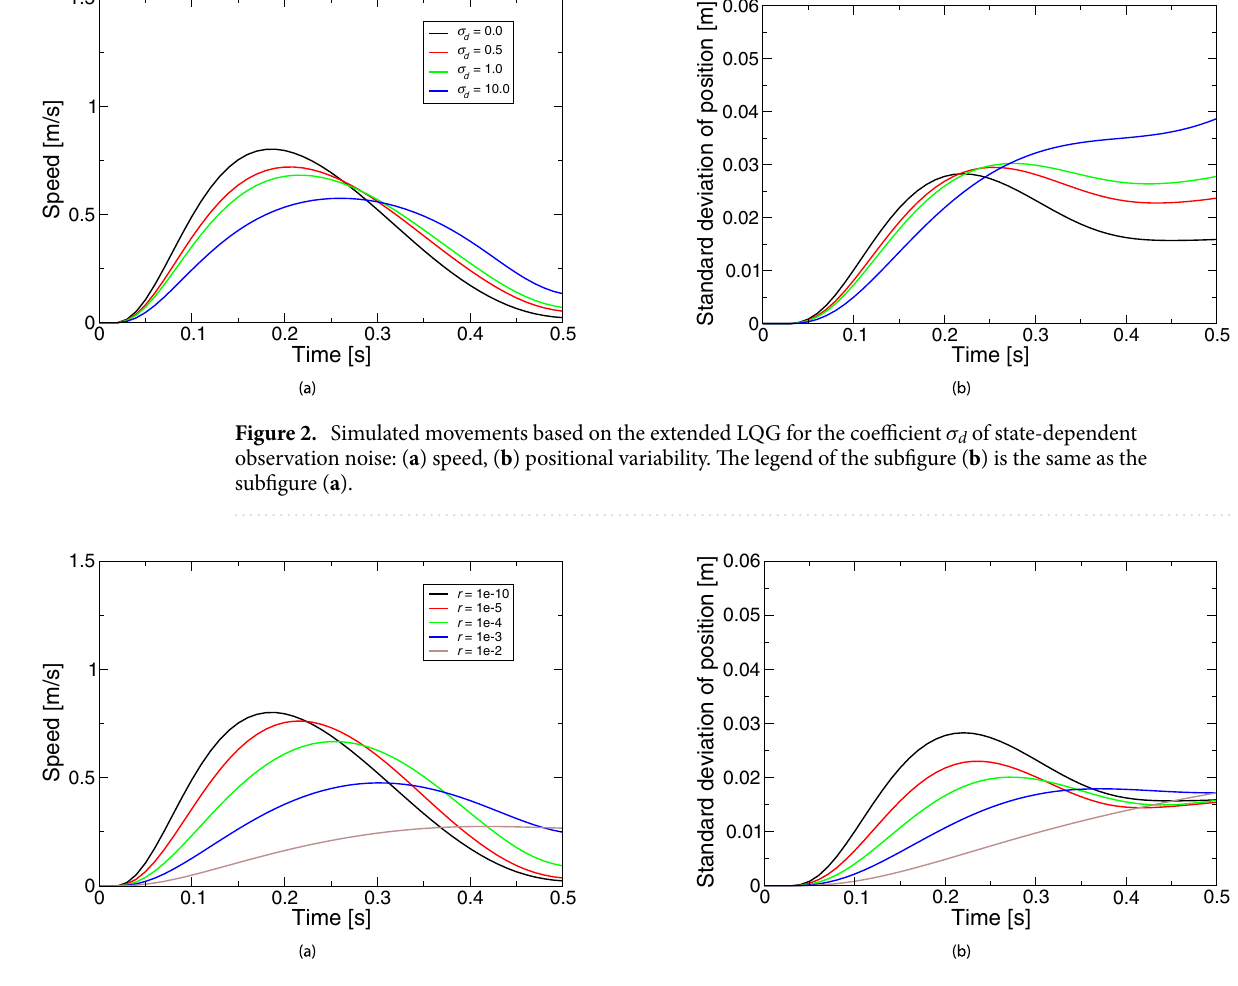
Figure 3. Simulated movements based on the extended LQG for the coefficient r of control cost: ( a ) speed, ( b ) positional variability. The legend of the subfigure ( b ) is the same as the subfigure ( a ).